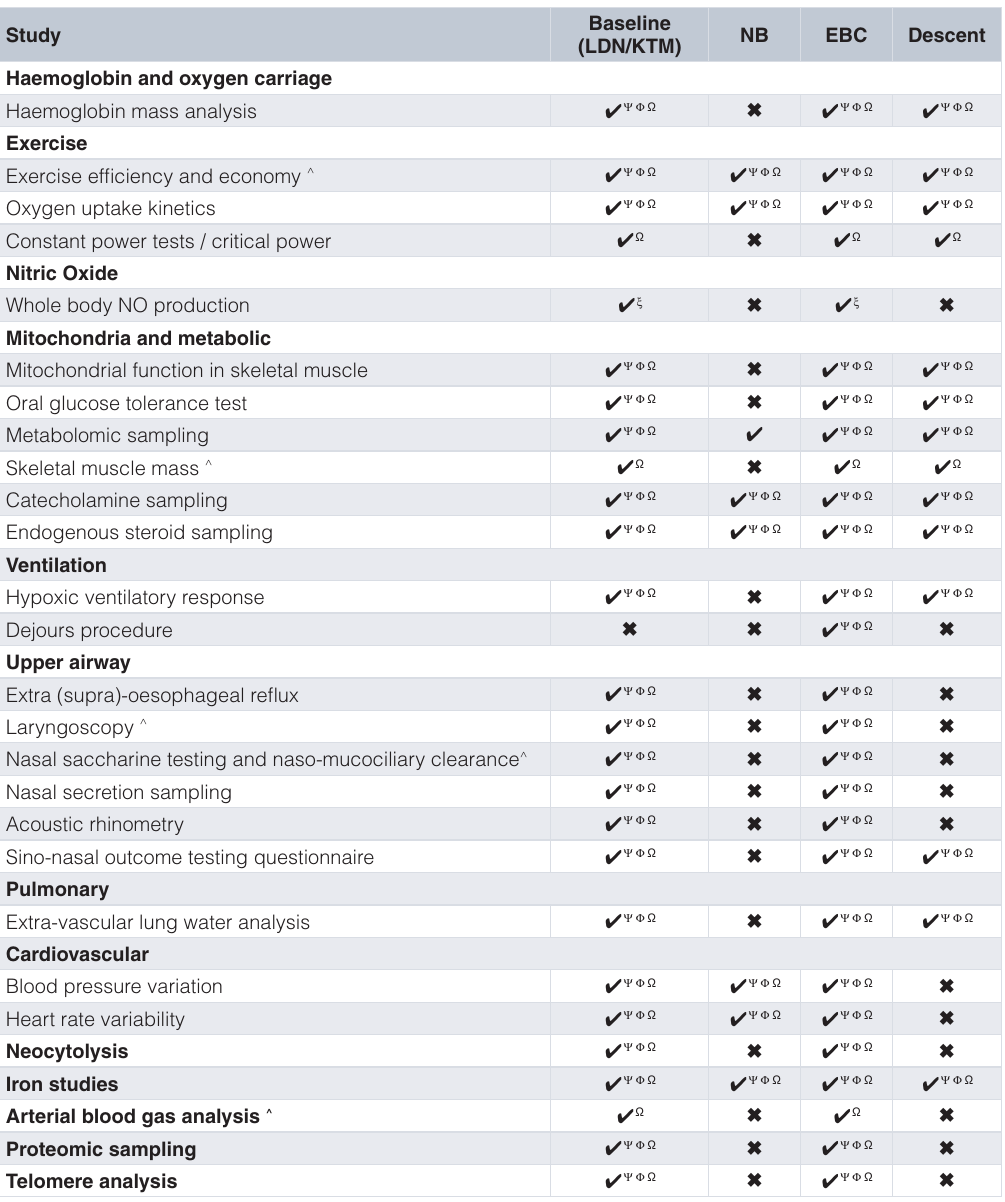
Table 4. Additional studies conducted on XE2, highlighting at which lab and in which